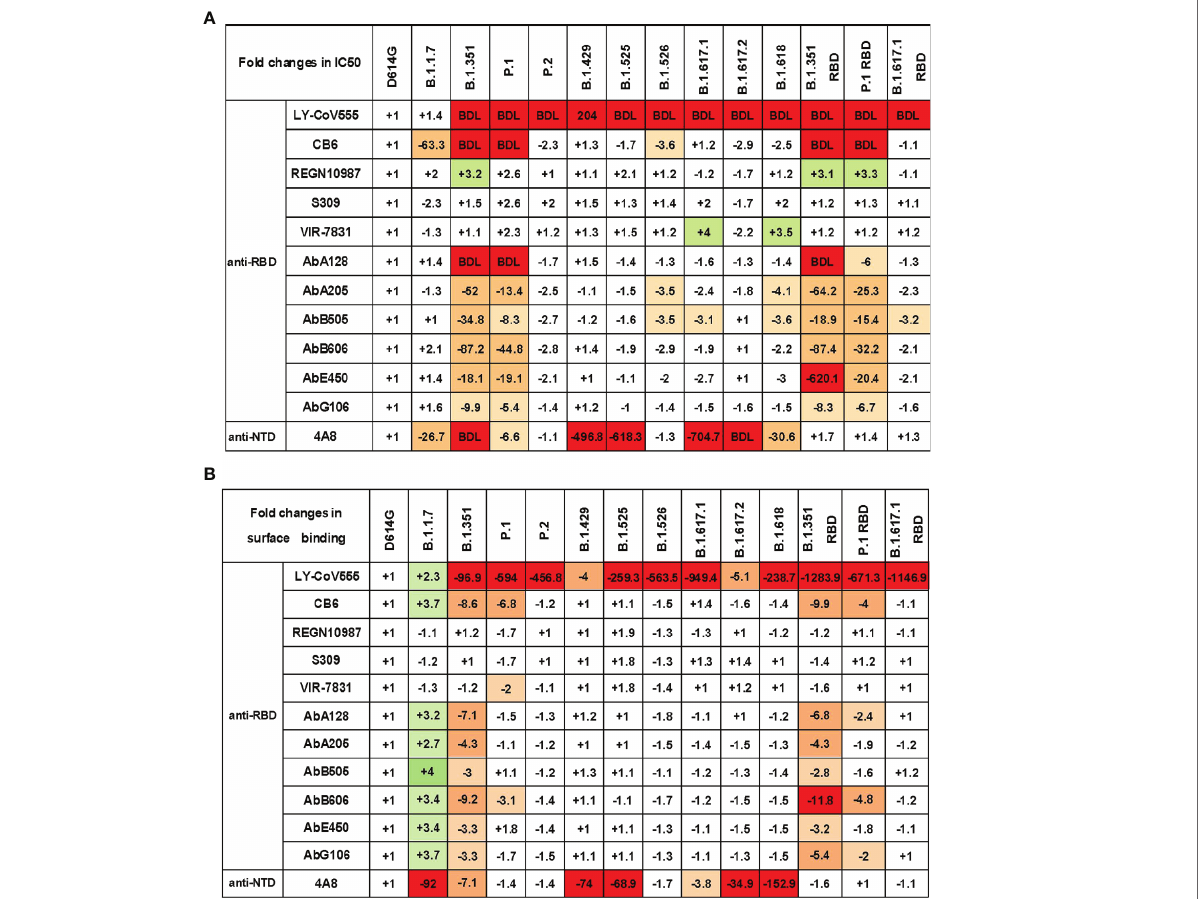
B1.617.1, and B.1.618, as well as B.1.351 RBD and P.1 RBD ( Figure 5C and Figure S6 ). For BBIBP-CorV vaccine serum samples, when compared with the neutralization activity to D614G, the sera had equal activity in neutralizing B.1.1.7, B.1.429, and B.1.525 ( Figures 5F – H ), while